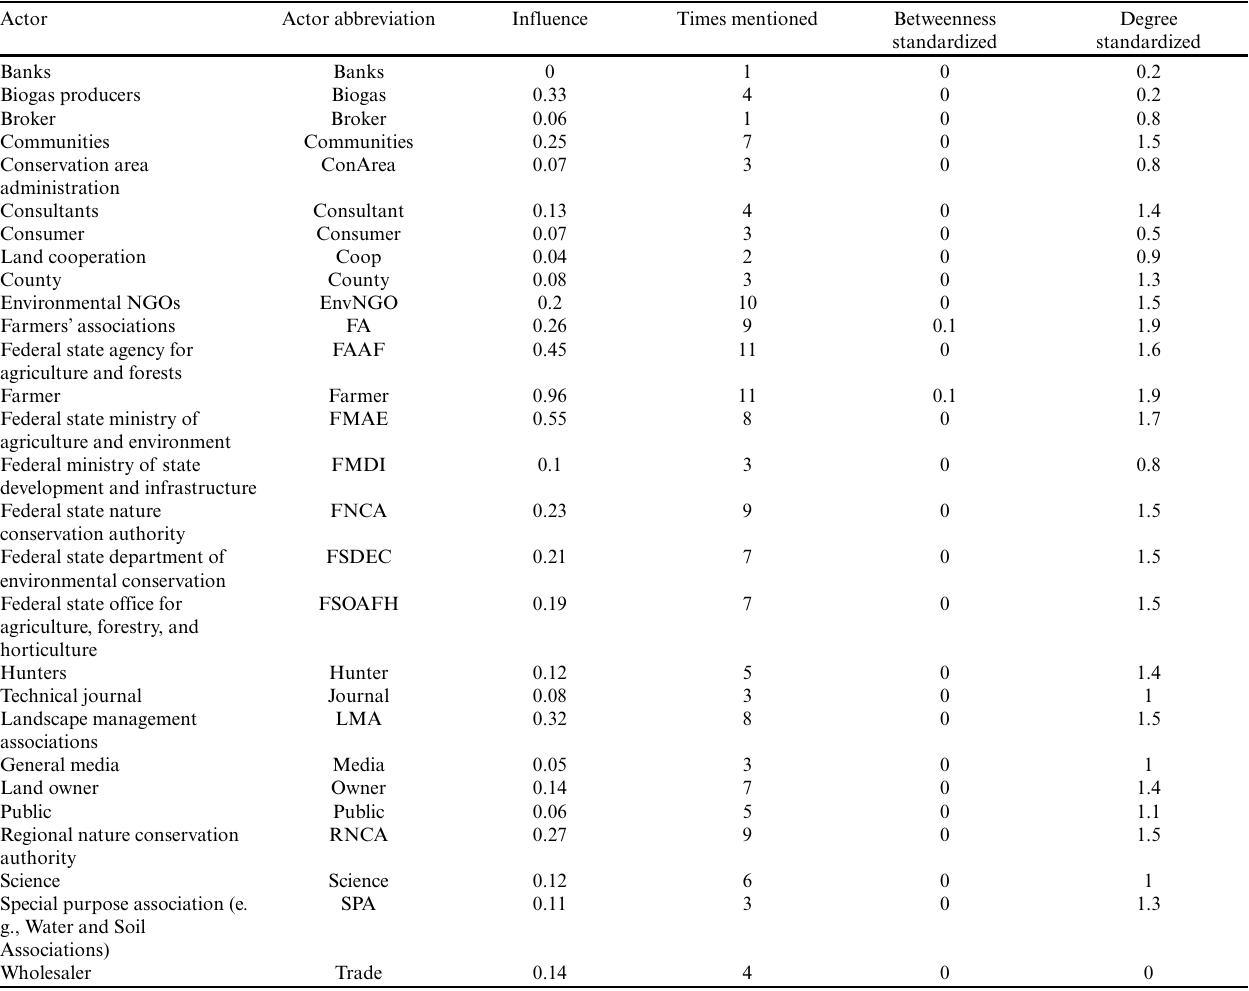
Table 1 . The table presents the results of the interviews at the regional level concerning the average influence of the actors, the number of times the actors were mentioned, standardized betweenness centrality, and standardized degree